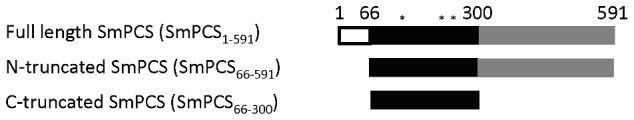
Three different constructions of SmPCS used in the study.The conserved N-terminal PCS region is shown in black, the variable C-terminal region in gray and the predicted mitochondrial peptide signal in white. The asterisks show the position of the three catalytic residues (Cys, His, Asp).